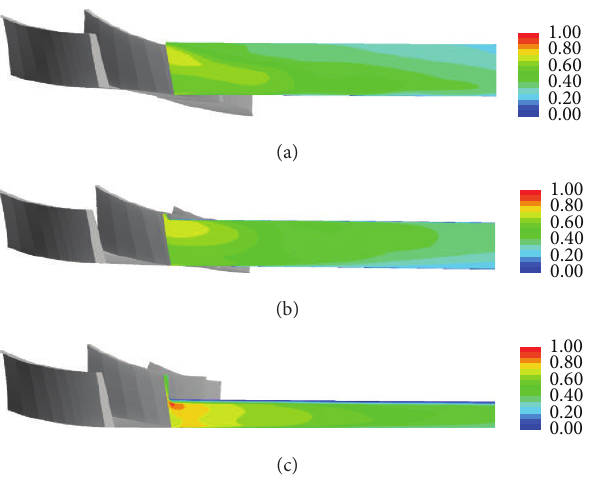
Figure 12: Absolute Mach number in the diffuser taken in the middle of the flow passage in circumferential direction. Top 𝑏/𝑏 2 = = 0.85 , and bottom 𝑏/𝑏 = 0.50 . 1.00 , middle 𝑏/𝑏 2 2